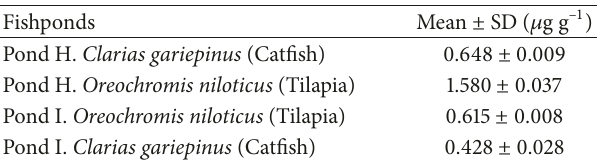
Table 3: Mean FA concentration and standard deviation (SD) in fish from